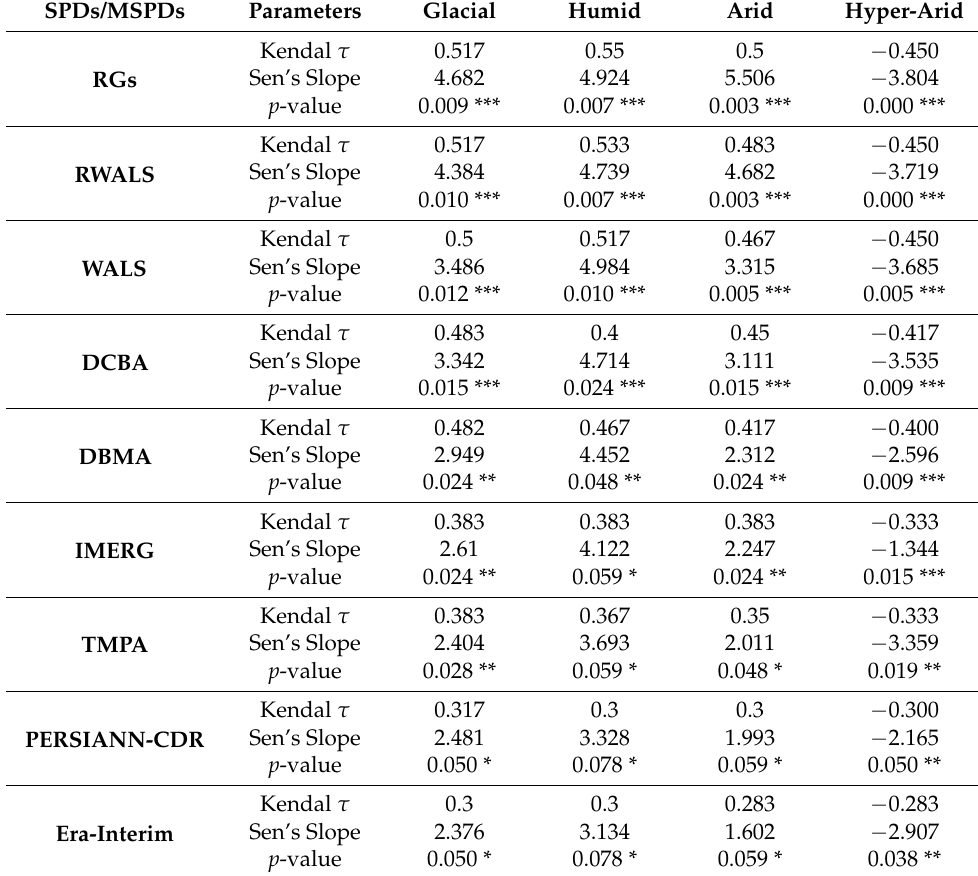
Table 9. MK trend and level of significance for SPI-12 estimated for RGs, SPDs, and MSPDs across all climate regions. The p -values less than 0.01, 0.05, and 0.10 show that the trend is significant at the significance level of 1%, 5%, and 10% and marked with ***, **, and *,